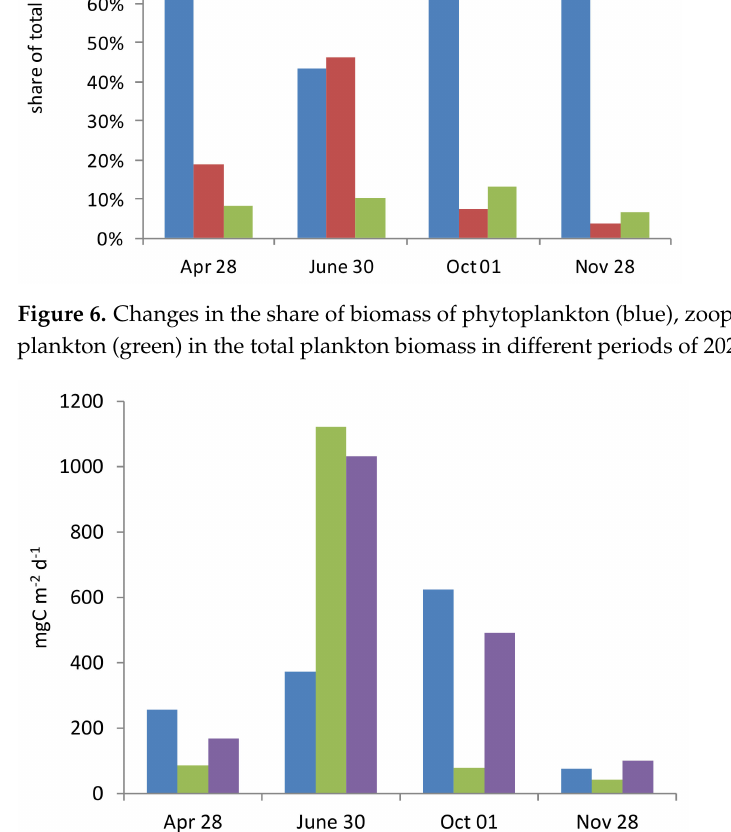
Figure 7. The ratio of the integral functional characteristics of the plankton community—primary production (blue), zooplankton ration (green), and bacterial carbon demand (violet)—in different periods of